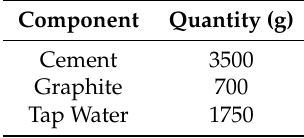
Table 4. Materials used in fabricating the smart plate.